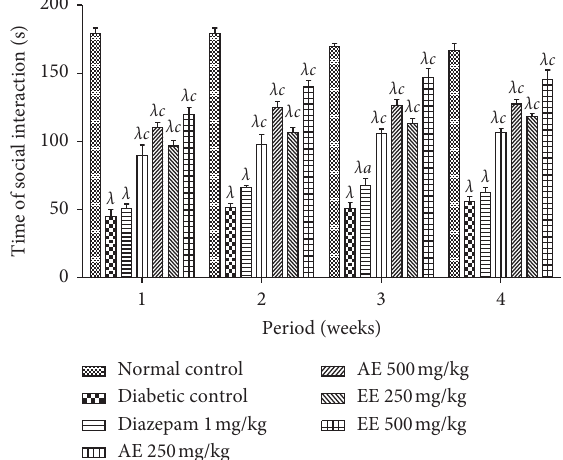
Figure 10: Effects of the aqueous (AE) and ethanol (EE) extracts of Dissotis thollonii on the absolute time spent for social interaction during 5min. Values are expressed as mean ± SEM for six animals and analyzed by two-way ANOVA followed by Bonferroni post hoc test. λ p < 0 . 001 when compared with the normal control and a p < 0 . 05, c p < 0 . 001 when compared with the diabetic control; s